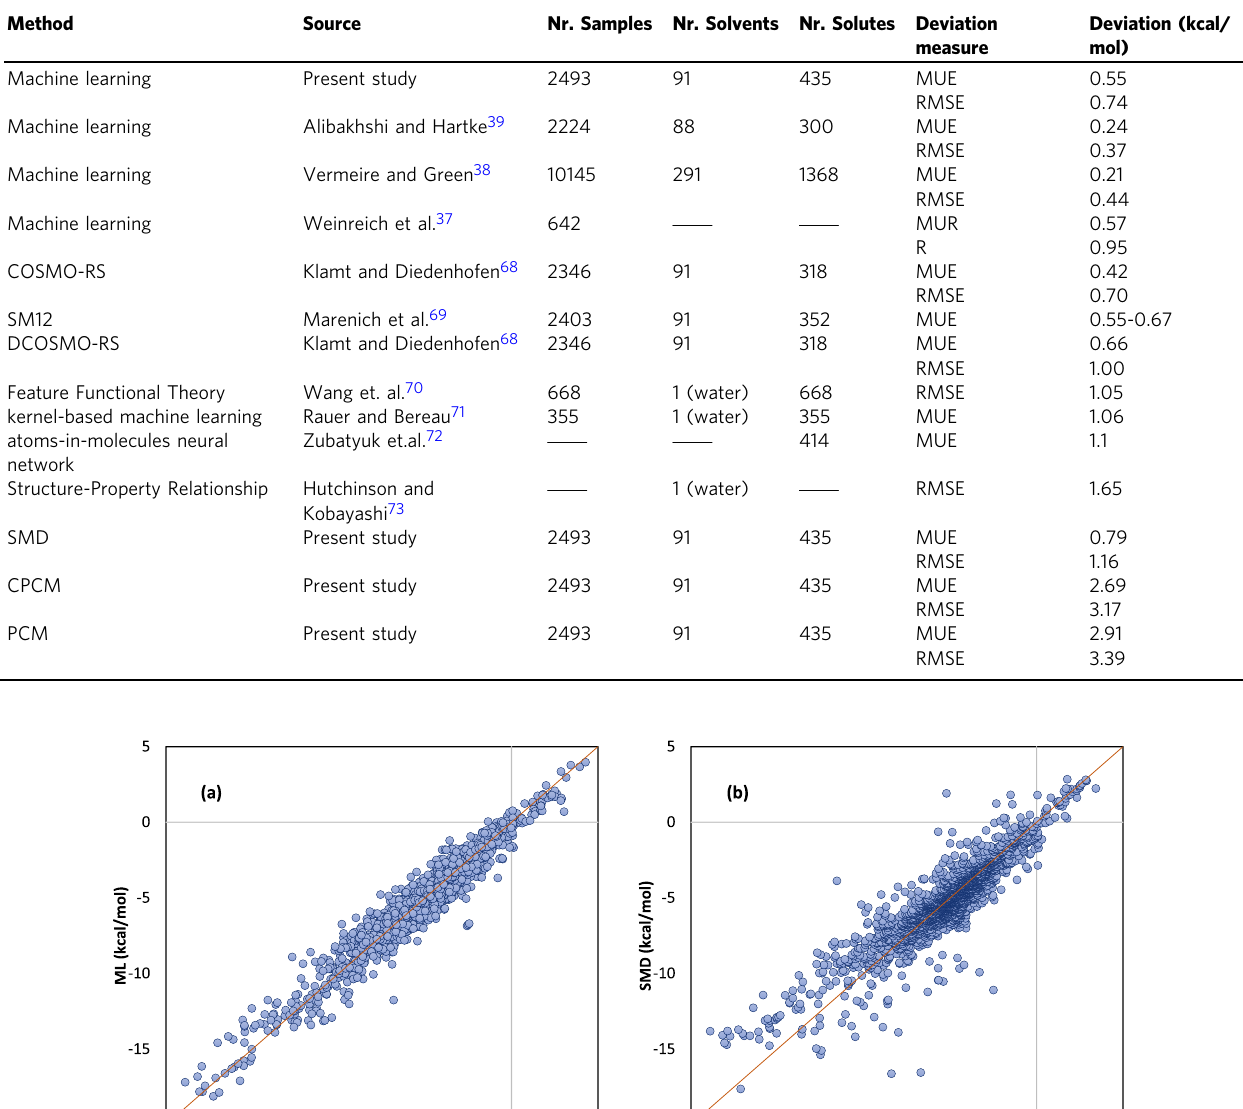
Table 1 Comparison of the results of the new method with other models for solvation free energy prediction.